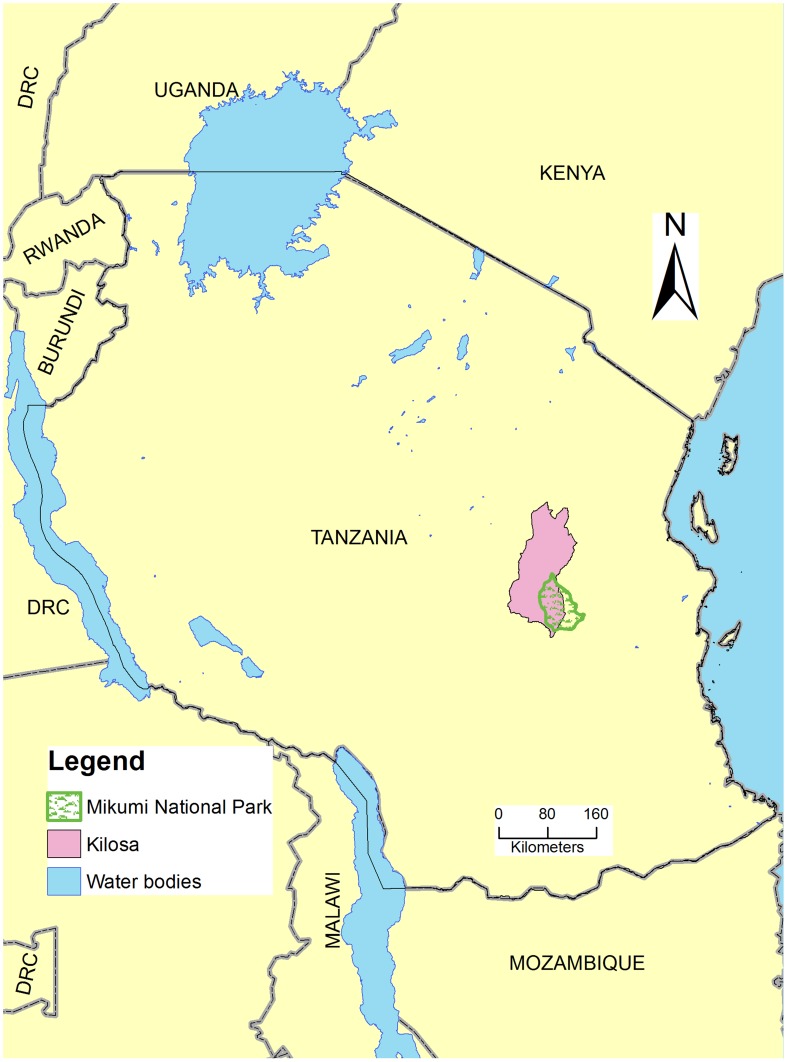
Map of Tanzania showing the study area.